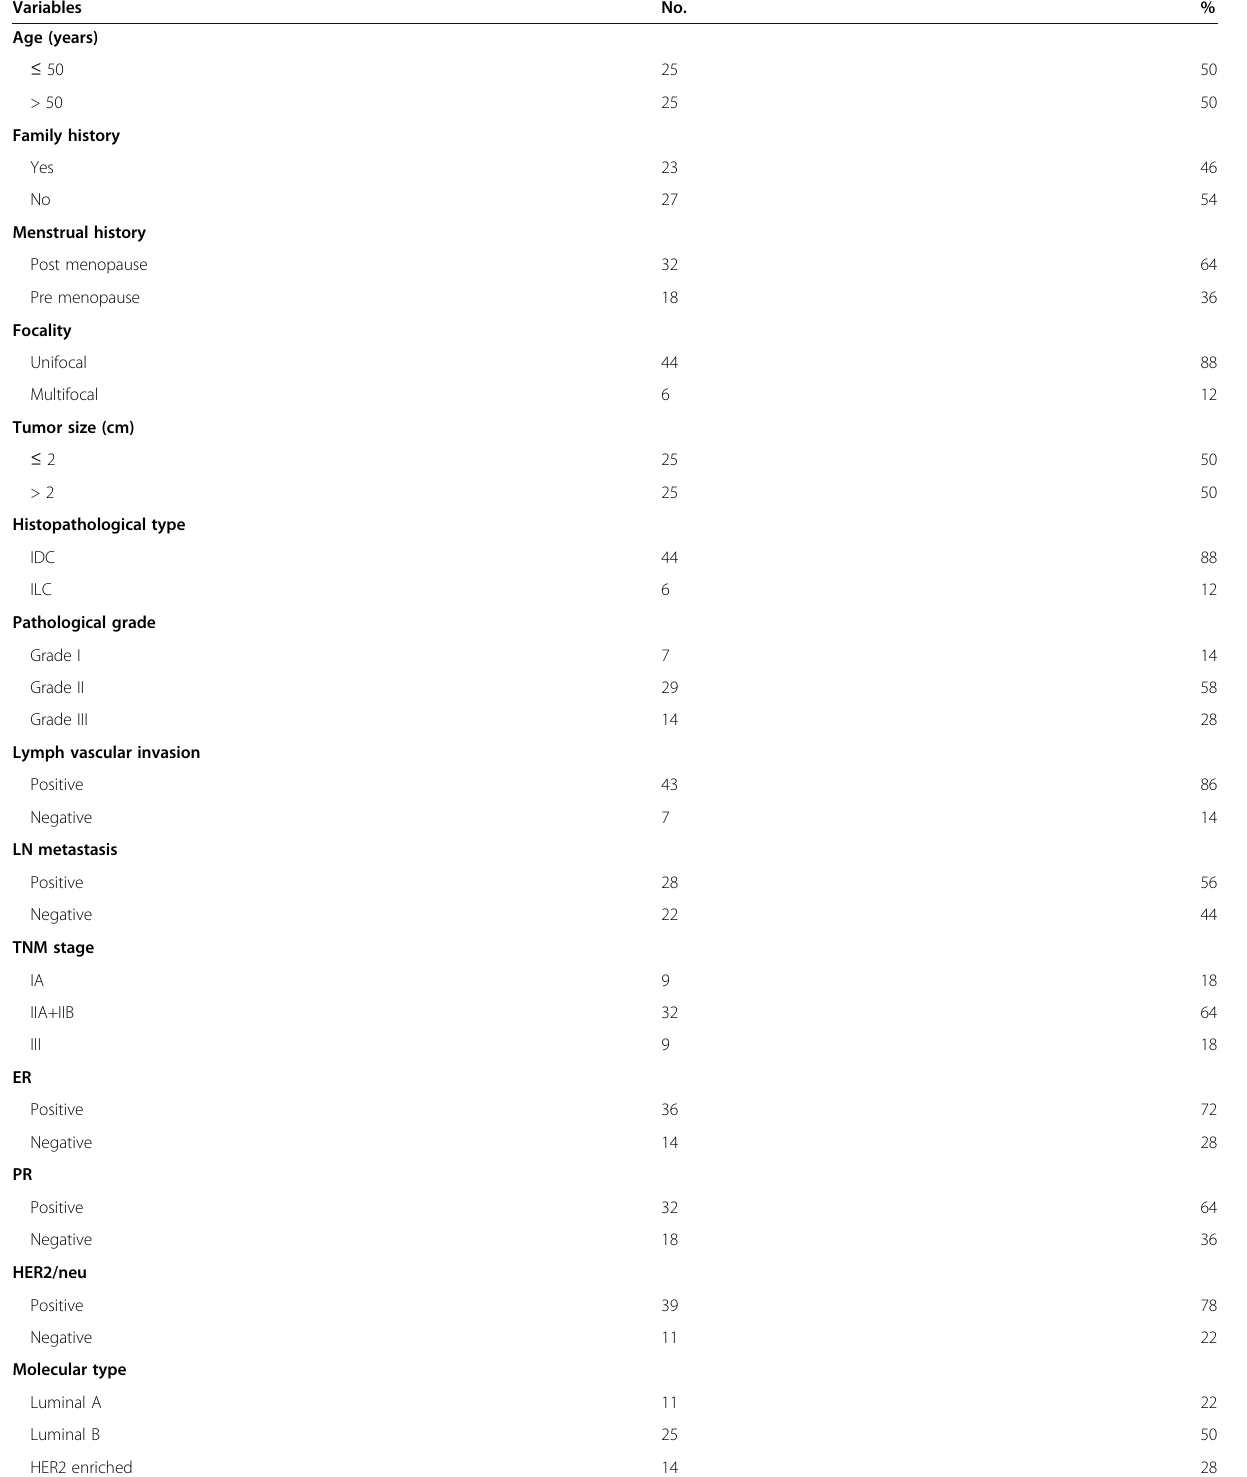
Table 2 Patients and tumor characteristics (N =